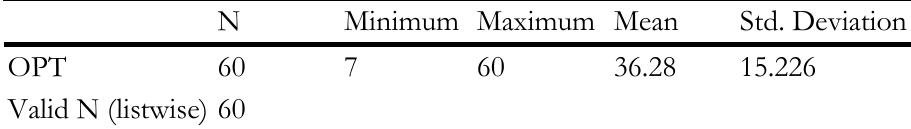
Table 1. Descriptive Statistics of the Participants’ OPT